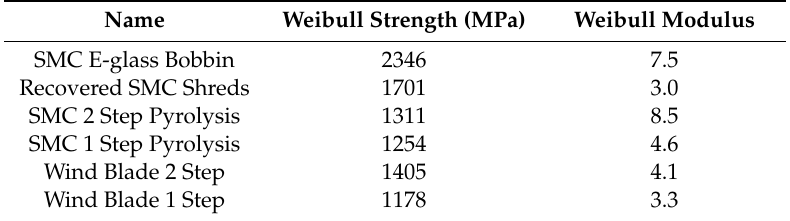
Figure 4. Weibull probability plots of tested filament fracture strengths: ( a ) wind blade results, ( b ) SMC results. A leftward shift in sample data indicates a reduction in overall fiber tensile strengths. Table 1. Tabulated Weibull characteristic tensile strength results from single filament tension tests.